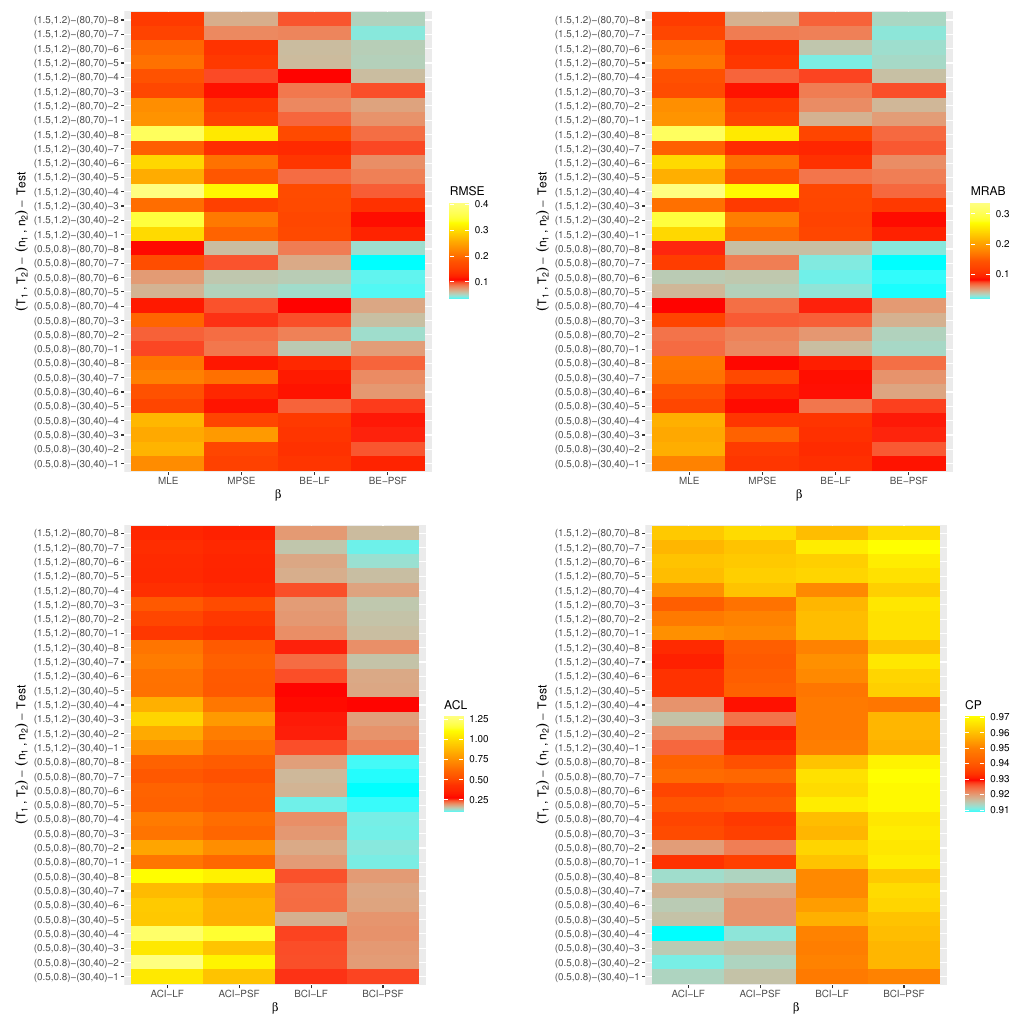
Figure 6. Heatmap for the estimation results of β using Set 2.